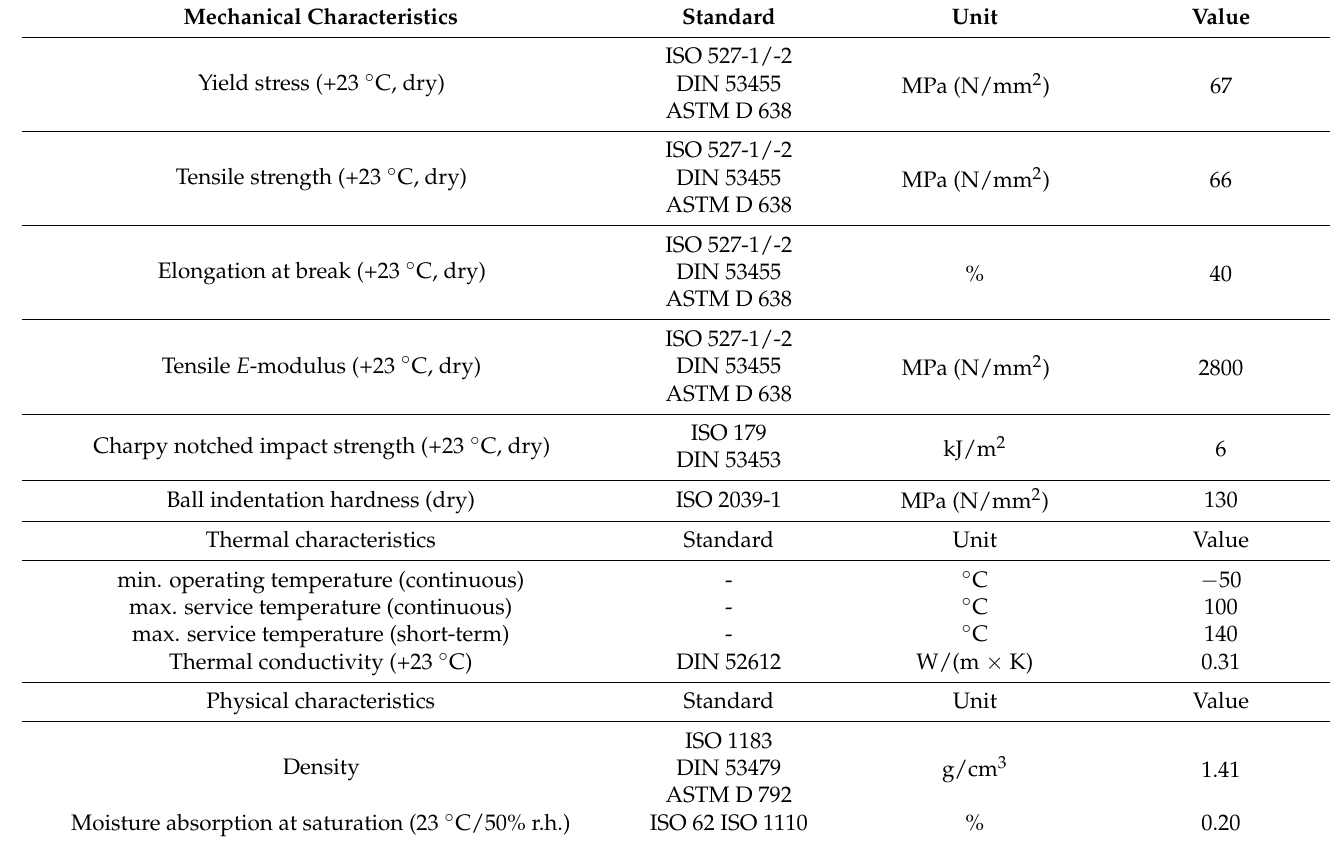
Table 1. Basic mechanical, thermal, and physical properties of the analysed POM (Adapted from [53], Faigle,